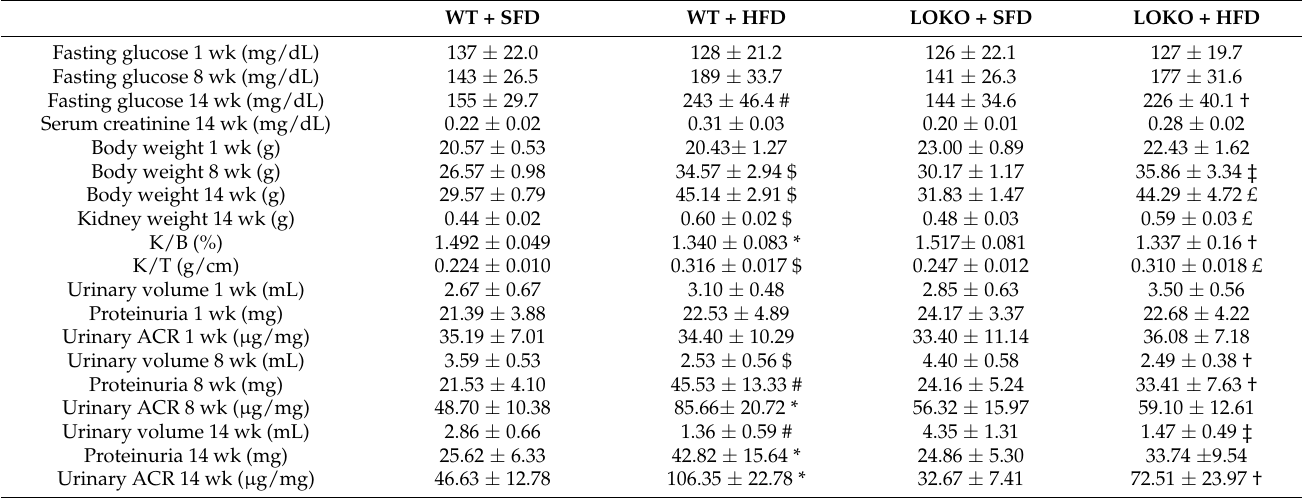
Table 2. Physiological parameters in experimental groups.